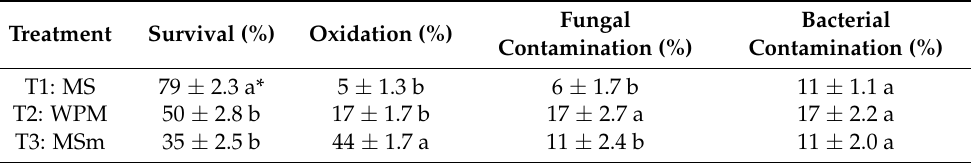
Table 1. Establishment of C. mucronata in vitro on different culture